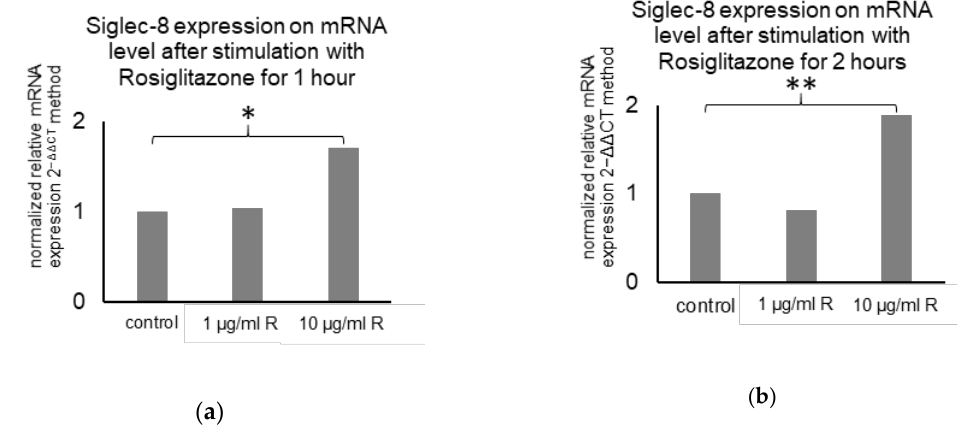
Figure 8. Mean Siglec-8 expression on mRNA level (calculated with the 2 − ∆∆ CT method) in MCF7 cells dependent on PPAR γ -stimulation. Expression in control cells is displayed and expression in cells stimulated with 1 or 10 µ g/mL Rosiglitazone for 1 ( a ) and 2 ( b ) hours is normalized on the expression in control cells. GAPDH was used as endogenous control for ∆ CT-values and the results are means of triplicates. * indicates a p -value < 0.05 and ** < 0.01.